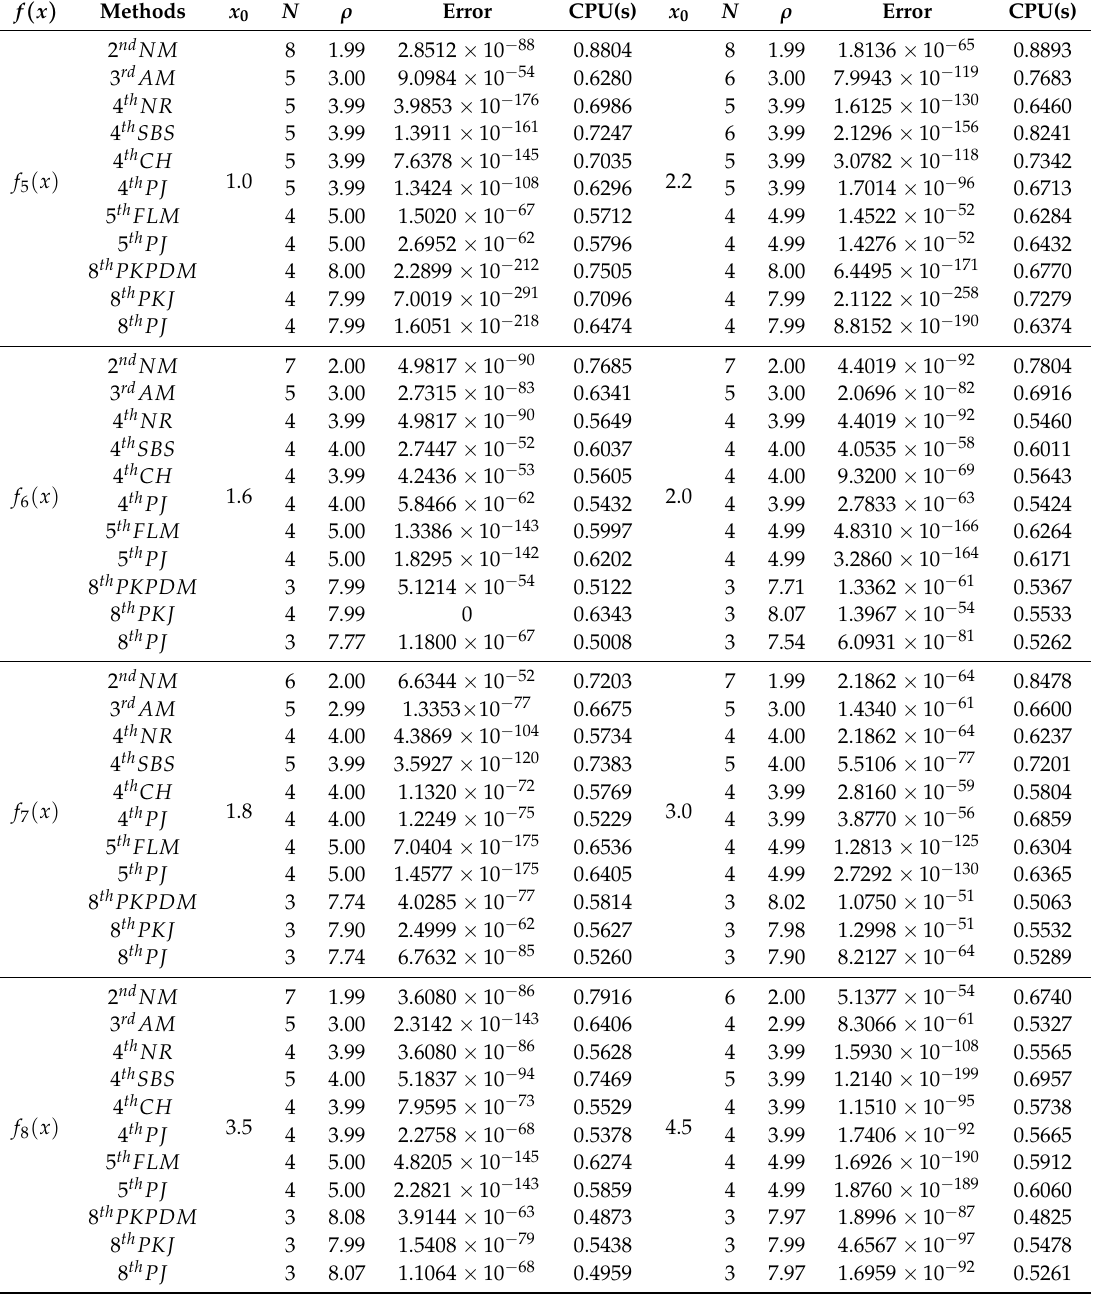
Table 3. Numerical results for test